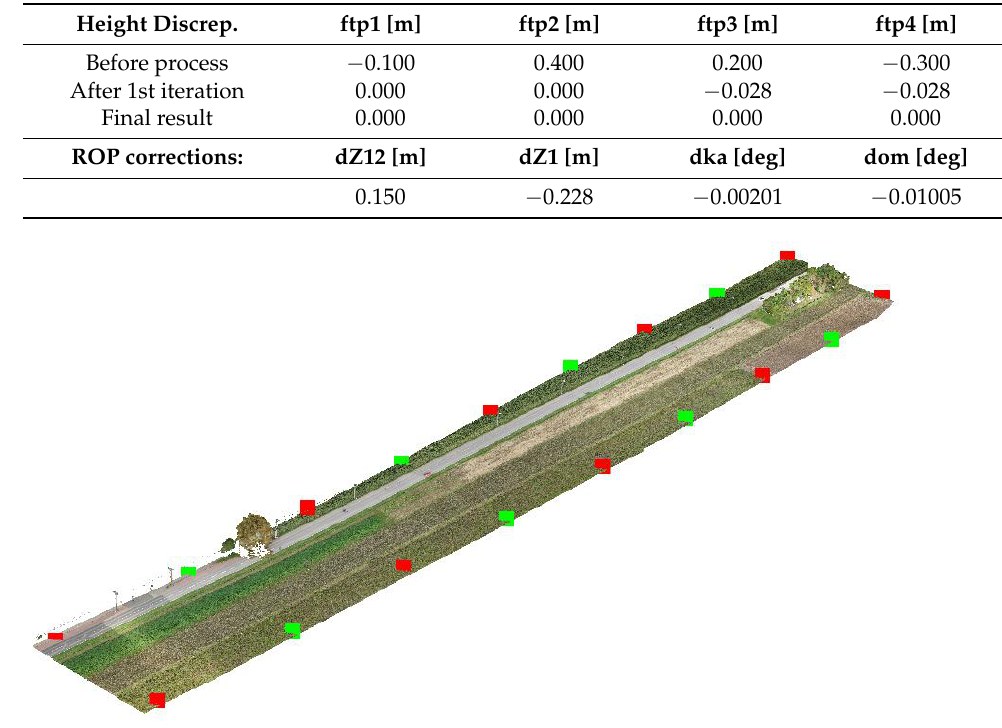
Table 2. Height discrepancies of four segments of real data before, during and after the process and final values of ROP corrections.